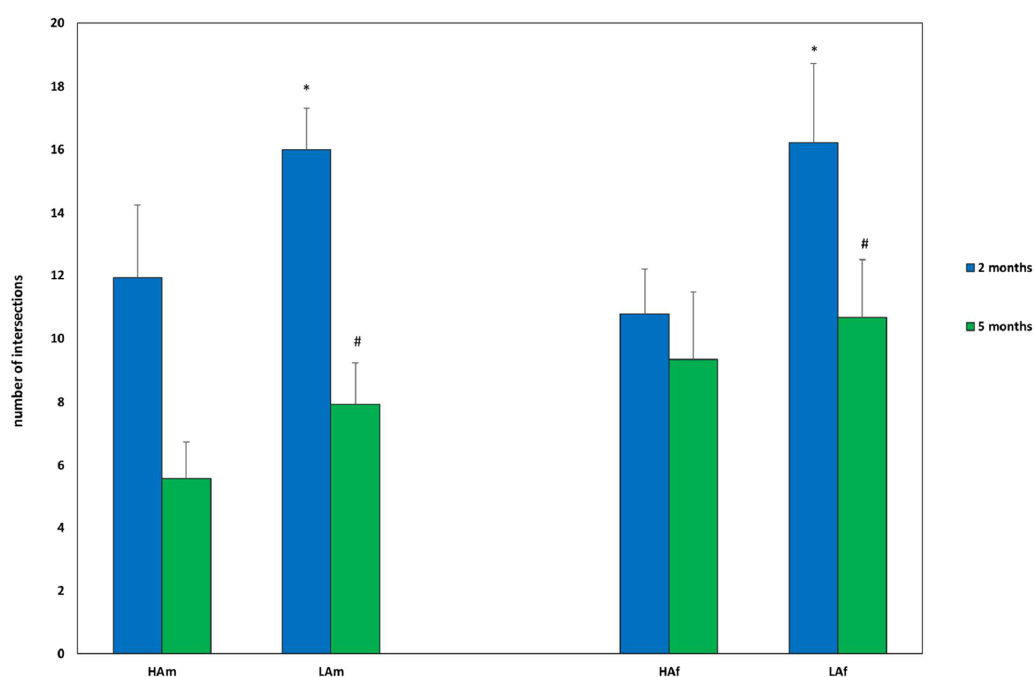
Figure 5. Time spent on the elevated plus maze open arms .